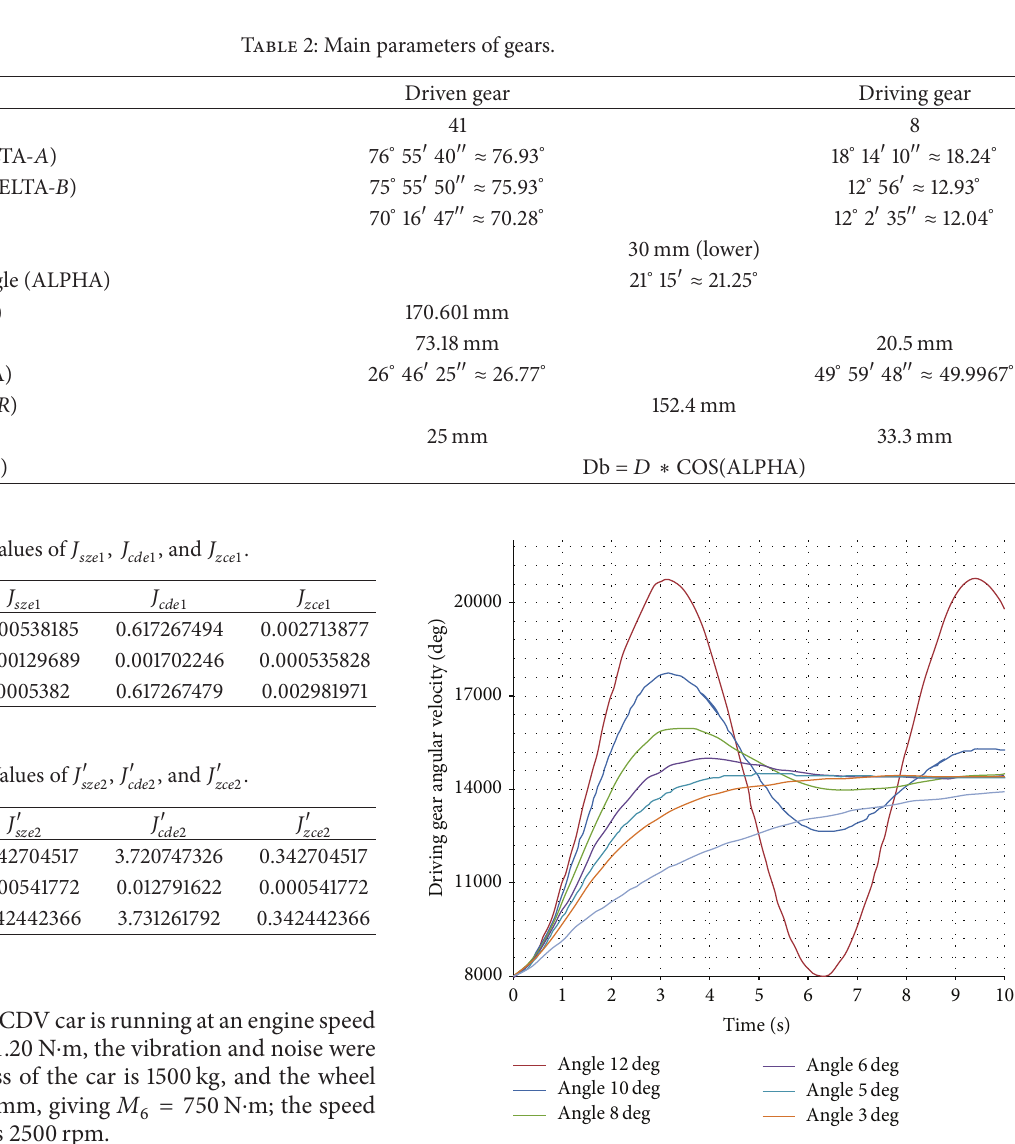
Figure 3: Response curve: driving gear angular